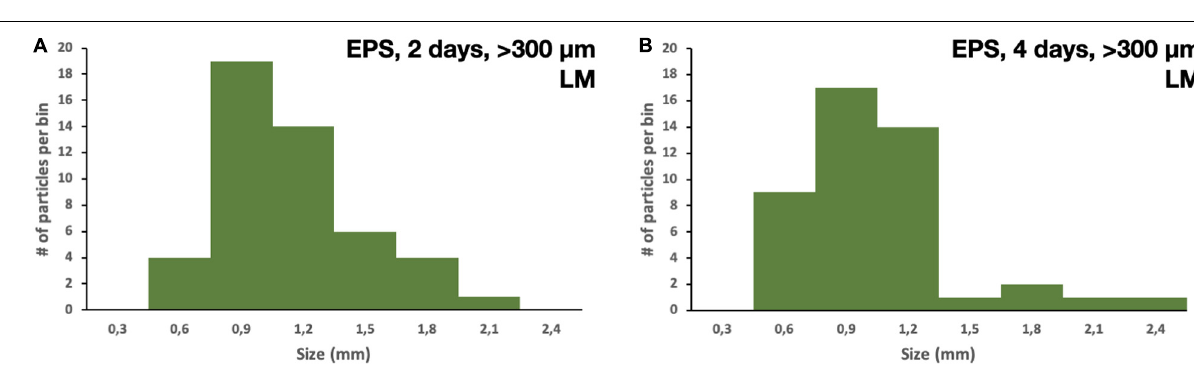
degraded EPS was more thermal aged than the undegraded